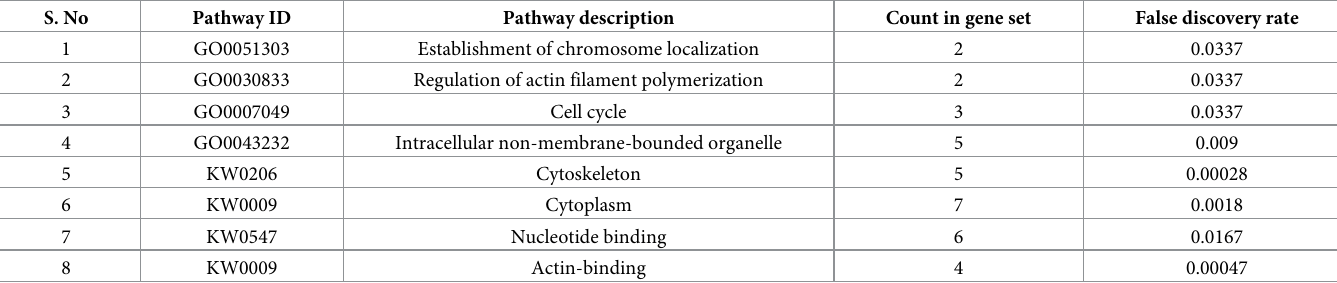
Table 3. Pathways downregulated by S . Enteritidis infected HTC cells. S. No